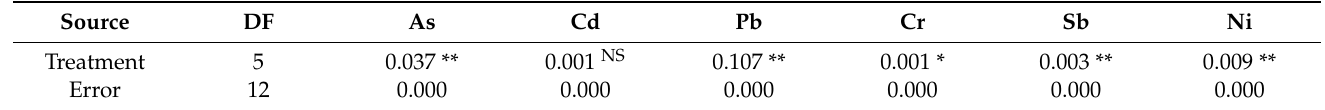
Table 2. Mean square of the effect of cooking conditions on the heavy metals of rice.